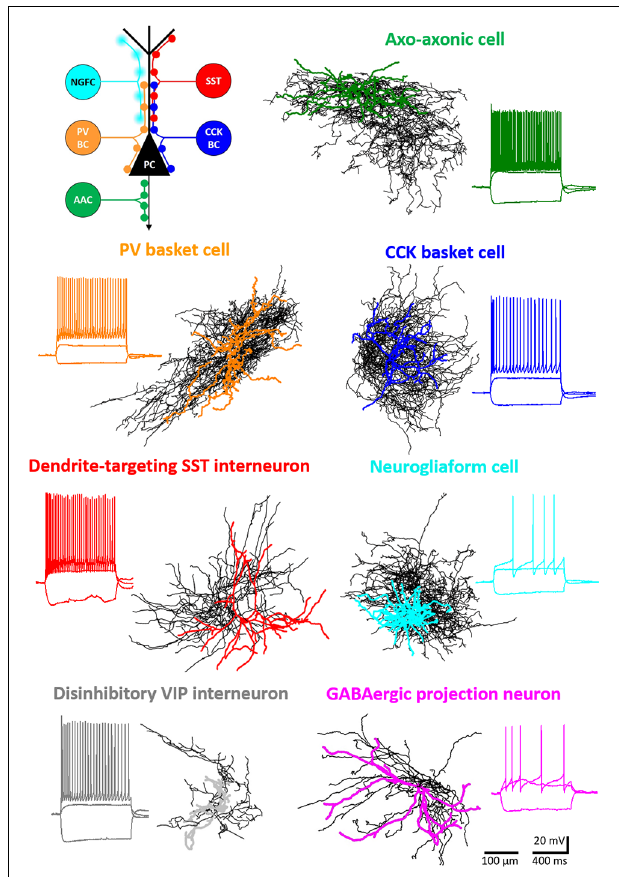
FIGURE 1 | Major inhibitory cell types in the basolateral amygdala (BLA). Intracellularly labeled GABAergic cells were sampled in slice preparations and reconstructed (dendrites in color, axons in black). Voltage responses to depolarizing and hyperpolarizing step current injections are shown for each example cell. Schematic (upper left panel) shows the different membrane domains of principal cells (PC) innervated by distinct interneuron types. NGFC, neurogliaform cells expressing NPY; SST, dendrite-innervating interneurons expressing somatostatin; PVBC, parvalbumin-containing basket cells; CCKBC, cholecystokinin-expressing basket cells; AAC, axo-axonic cells. the extent of the perisomatic region (Vereczki et al.,